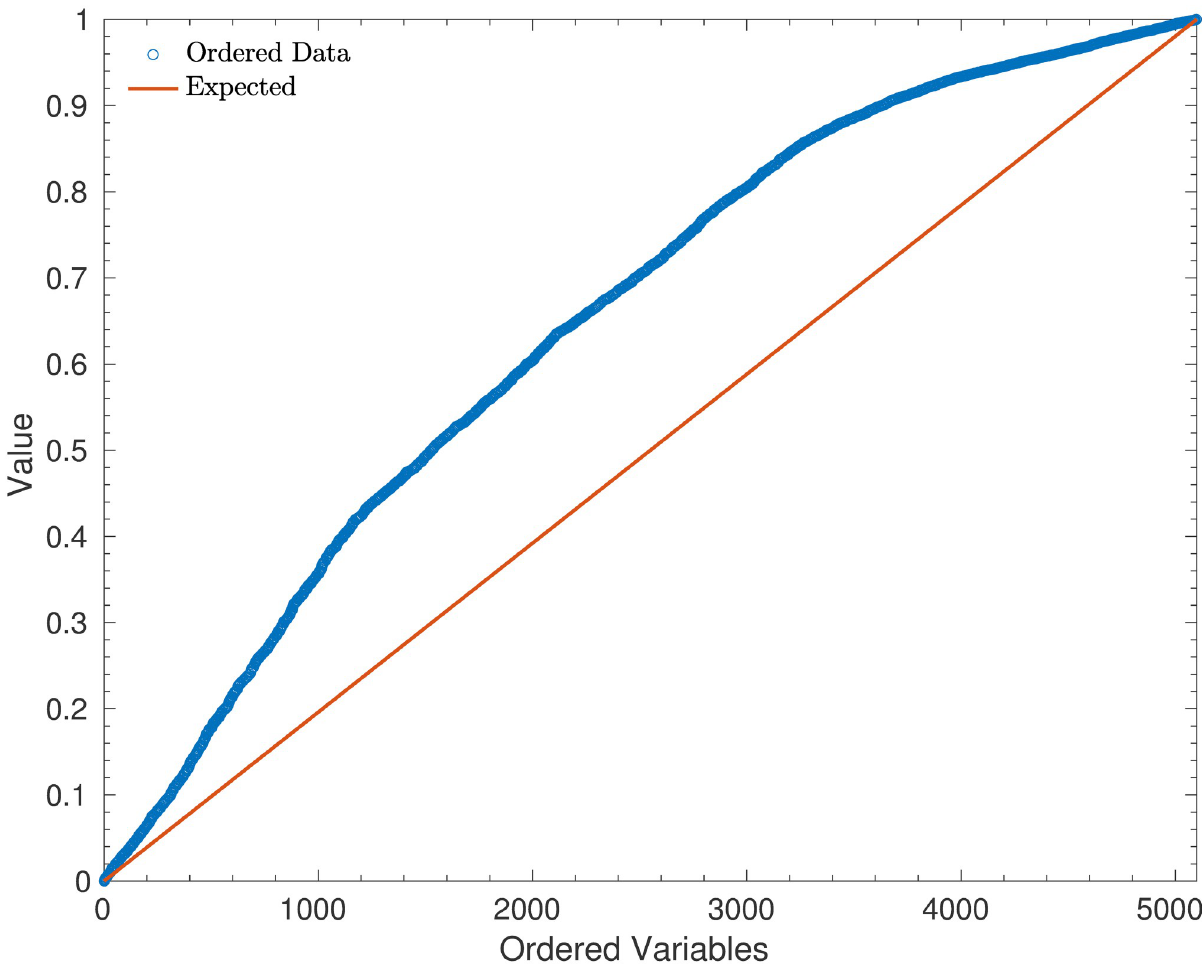
Fig 10. A Quantile-Quantile (QQ) plot for the re-generated uniform random variables. A QQ Plot for the uniform random variable simulations described in (30), conditional on the results of Euro 2020. Note that for each result, 100 uniform random variables were sampled in order to minimise variance in the